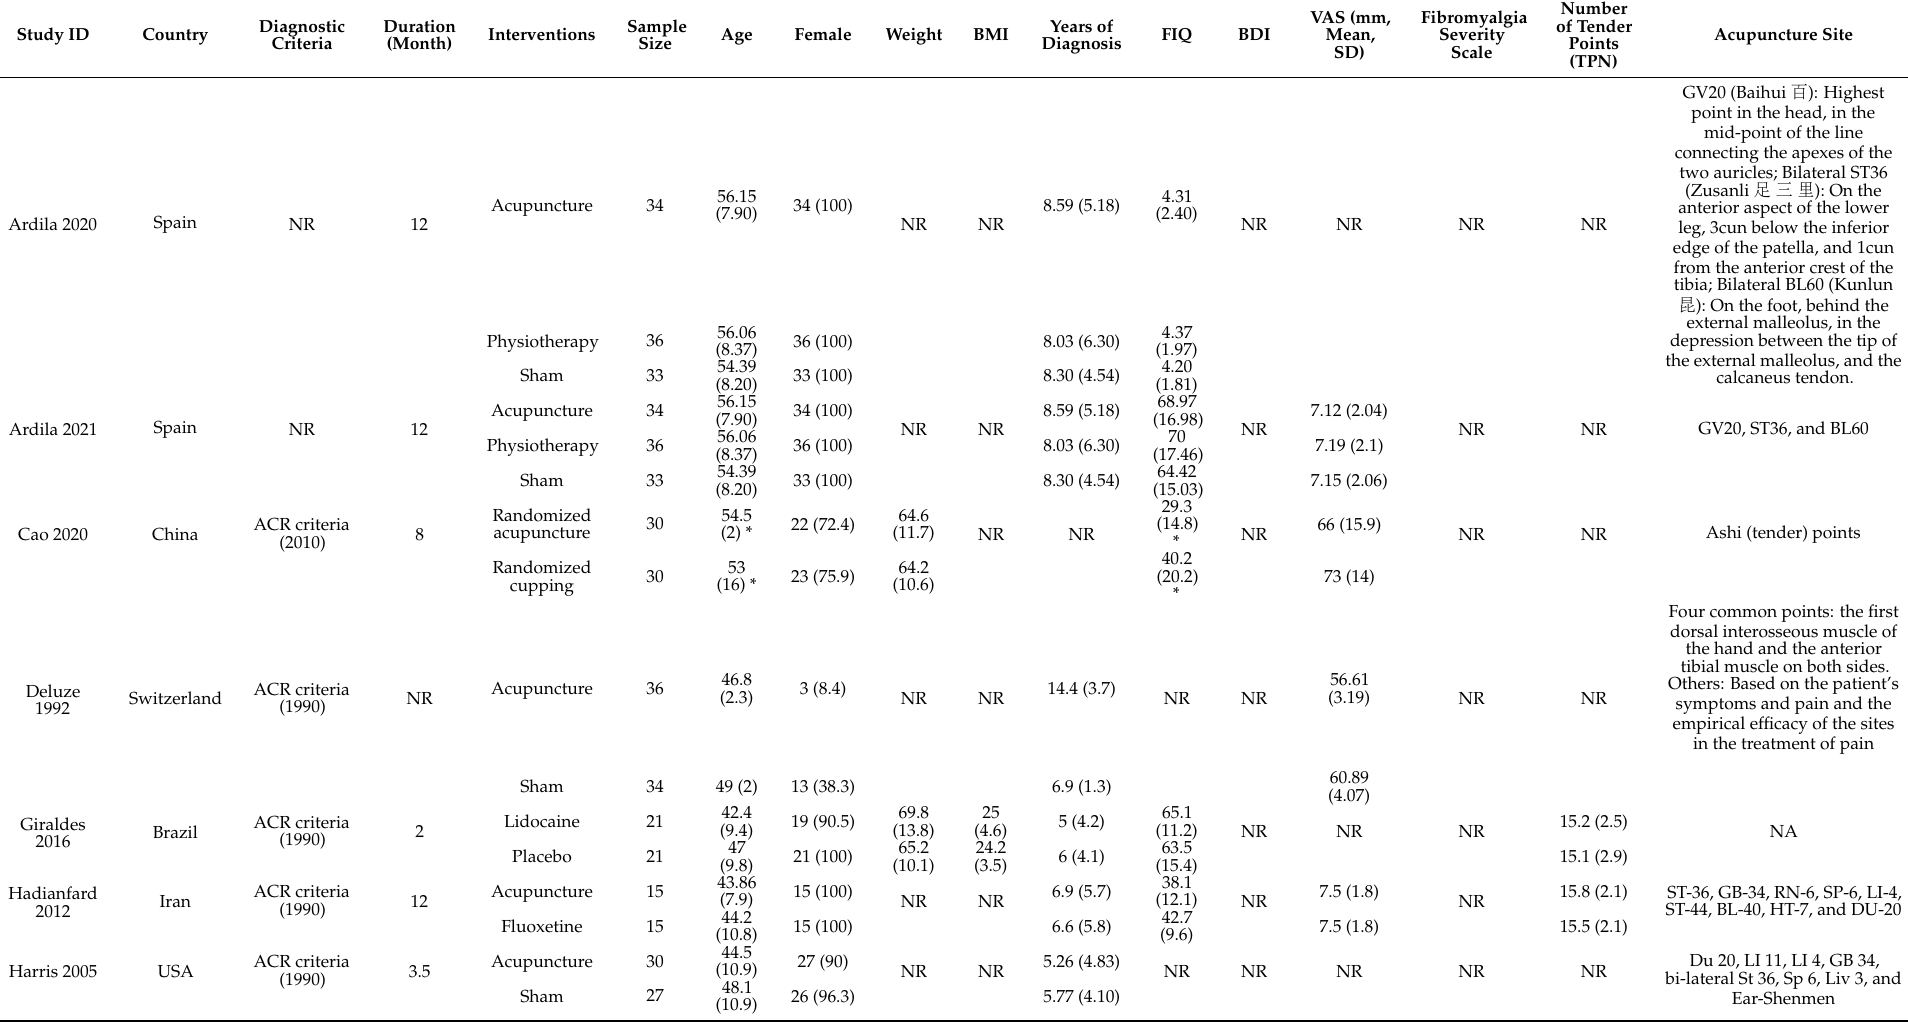
Table 1. Summary and baseline characteristics of the included